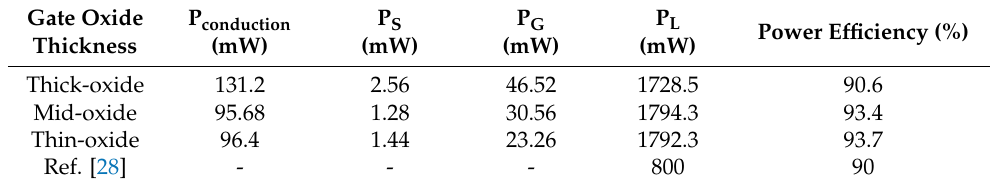
Table 1. Summary of overall power loss and power efficiency with different gate oxide technologies.